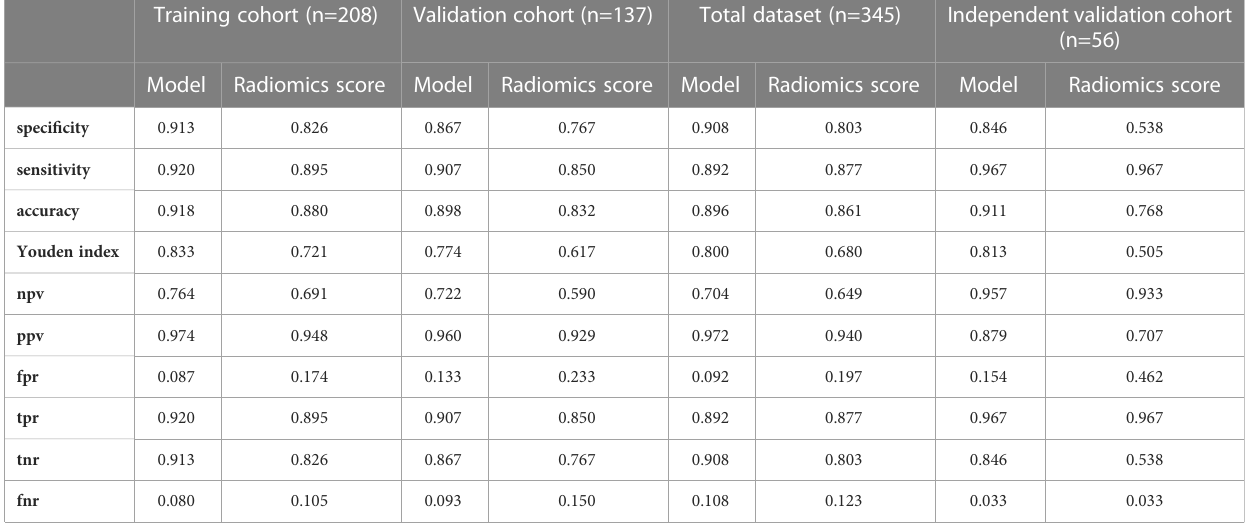
TABLE 5 The evaluation index of the radiomics score and